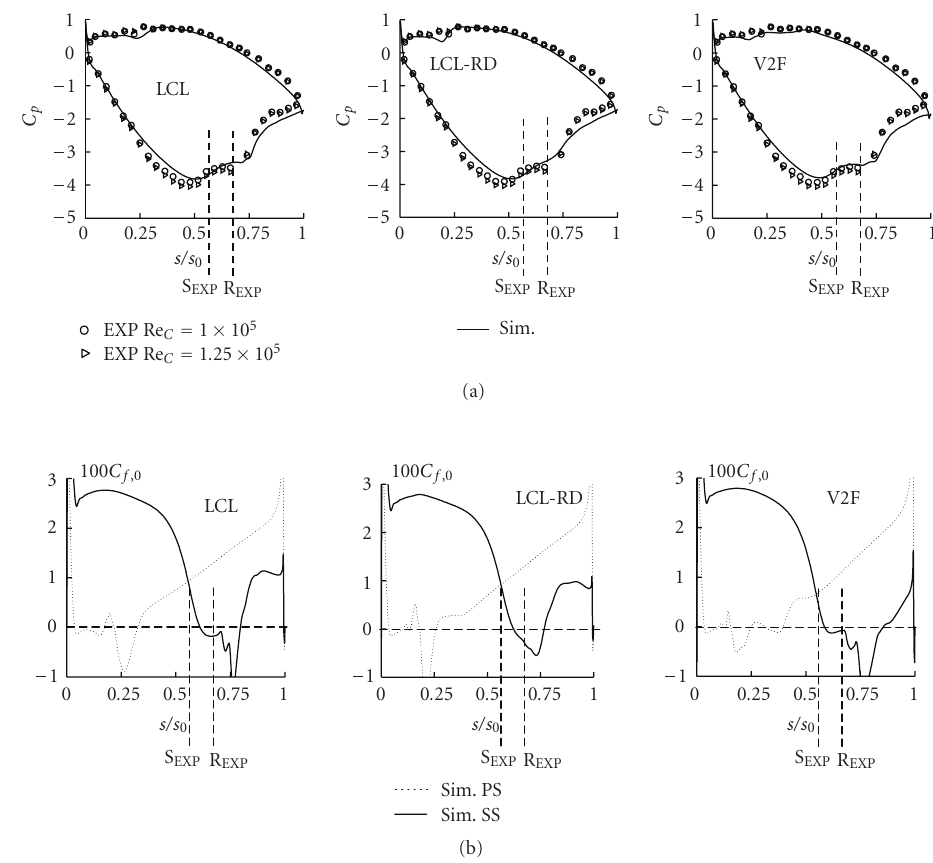
Figure 10: Pressure coe ffi cient and wall shear stress coe ffi cient for di ff erent turbulence models for the periodically disturbed